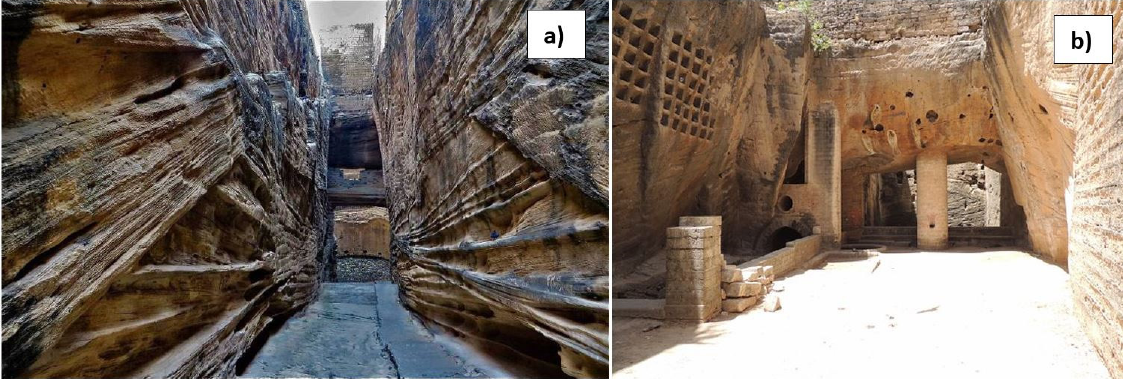
Figure 9. Navghan Kuvo stepwell in the Uparkot Fort complex. ( a ) Front view of slanting shaft driven into sandstone https://www.smithsonianmag.com/travel/review-vanishing-stepwells-india- 180962637/, accessed on 20 July 2022 and ( b ) forecourt surrounding the well https://www.travel- history.com/2021/05/navghan-kuvo-about-navghan-kuvo-history.html, accessed on 20 July 2022. Built between the 9th and 10th century, Chand Baori, Abhnaeri (27.0073° N, 76.6065°